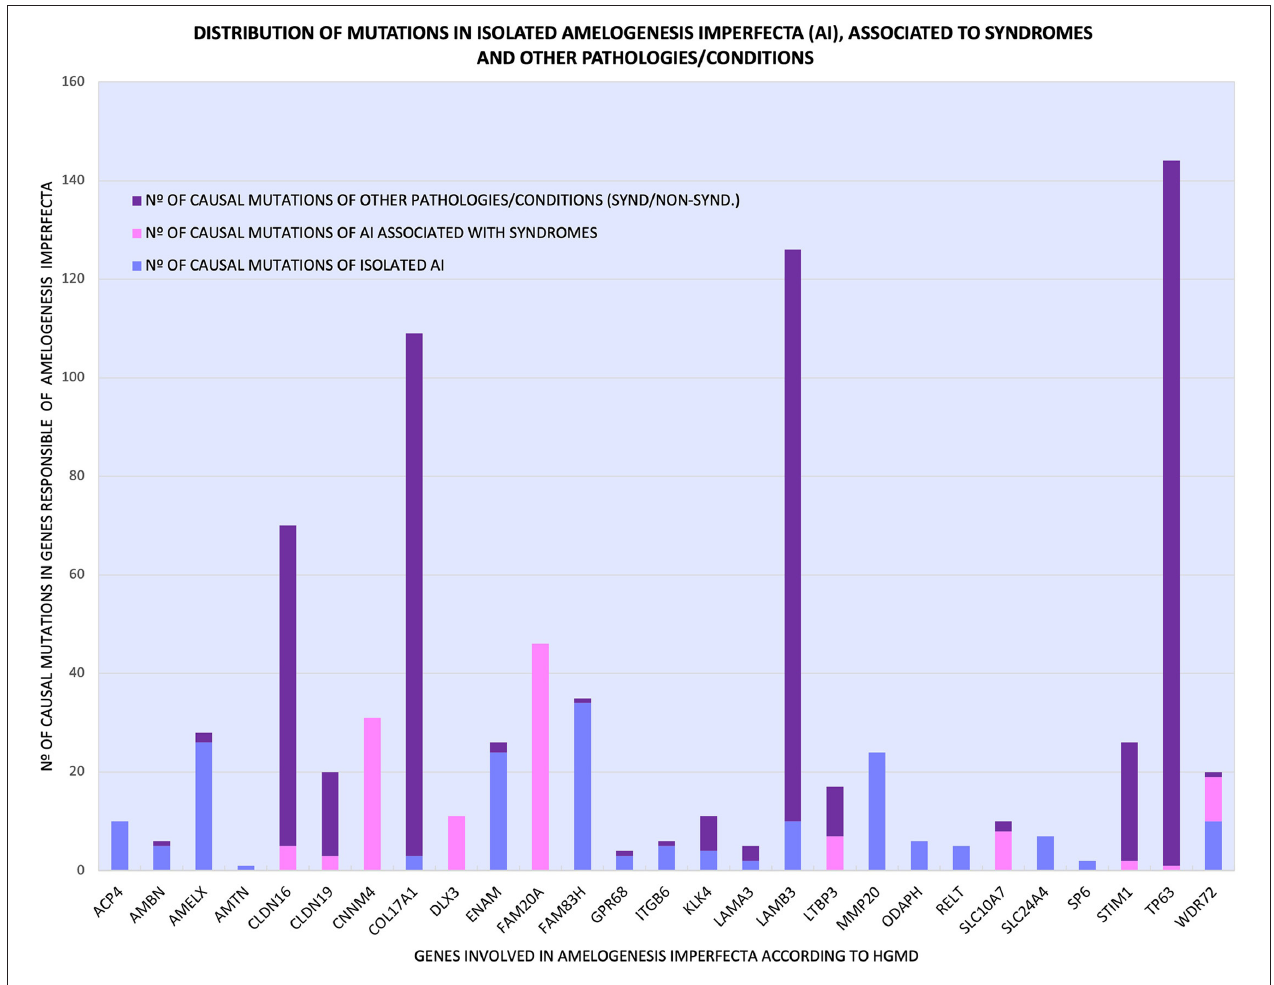
FIGURE 2 | Distribution of the various mutations of 27 genes that cause isolated AI ( ), AI related to syndromes ( ) and other pathologies/conditions ( ), syndromic and